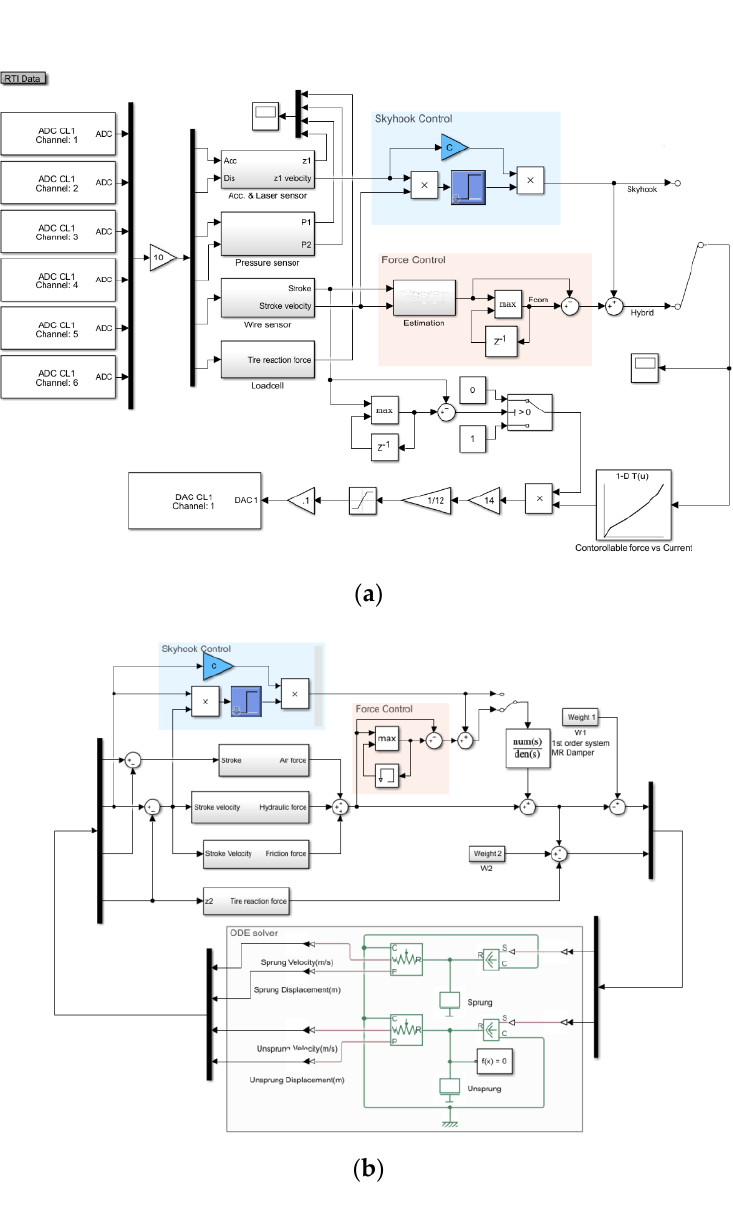
Figure 8. MATLAB/Simulink diagram: ( a ) Hybrid controller with dSPACE; ( b ) Simulation model using Simpscape.